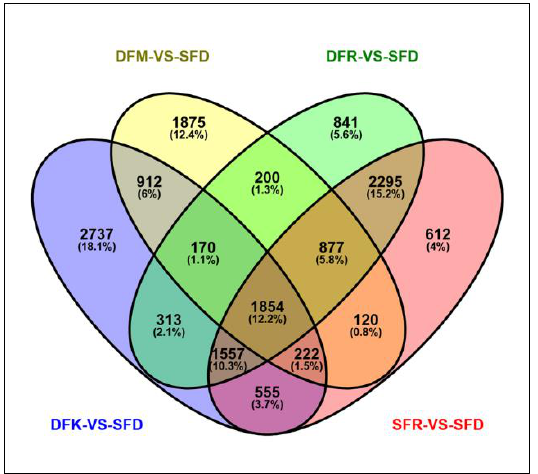
Figure 3. Illustration of all differentially expressed genes (DEGs) between single and double flower cultivars using a Venn diagram.